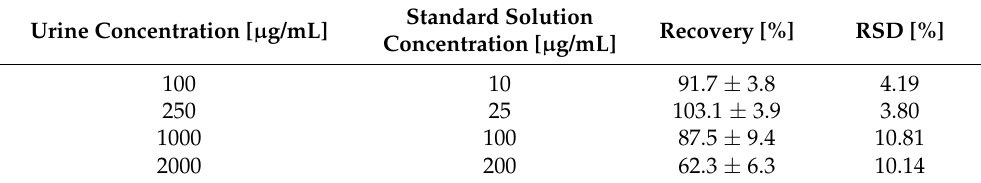
Table 4. Mean recovery values at four different concentration levels ( n =